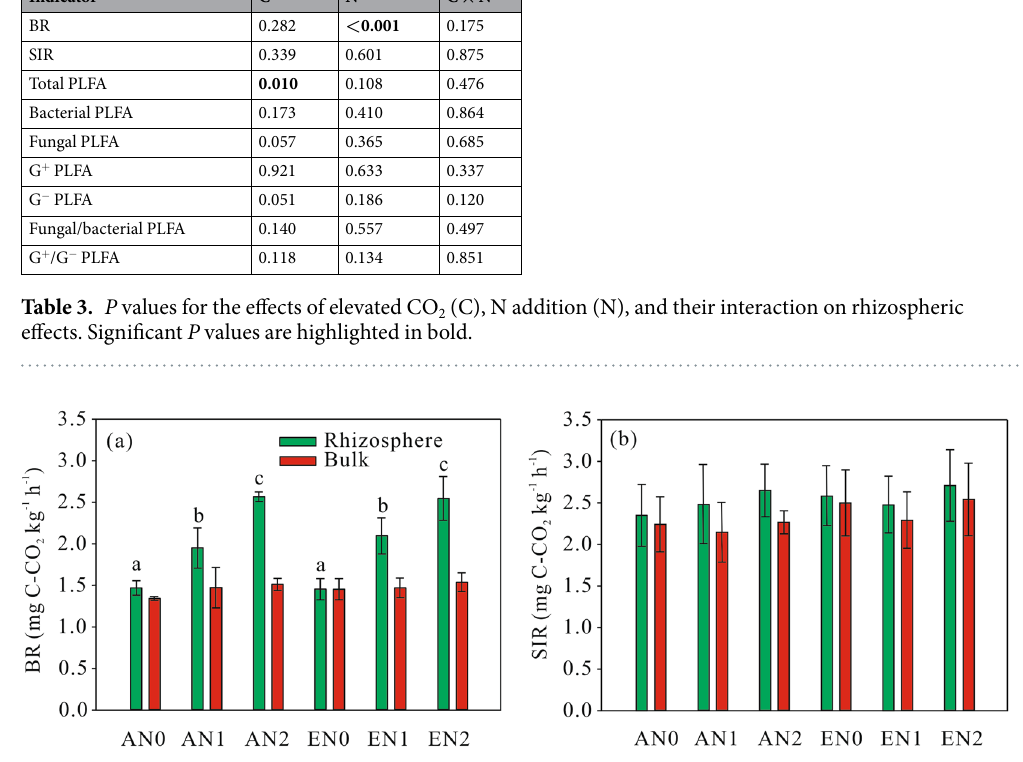
Figure 1. BR ( a ) and SIR ( b ) in the rhizosphere and bulk soil in the treatments. Different lowercase letters indicate significant differences between treatments in the rhizosphere. AN0, ambient CO 2 and no N added; AN1 ambient CO 2 and N supply at a rate of 2.5 g N m − 2 y − 1 ; AN2, ambient CO 2 and N supply at a rate of 5 g N m − 2 y − 1 ; EN0, elevated CO 2 and no N added; EN1, elevated CO 2 and N supply at a rate of 2.5 g N m − 2 y − 1 ; EN2, elevated CO 2 and N supply at a rate of 5 g N m − 2 y − 1 .